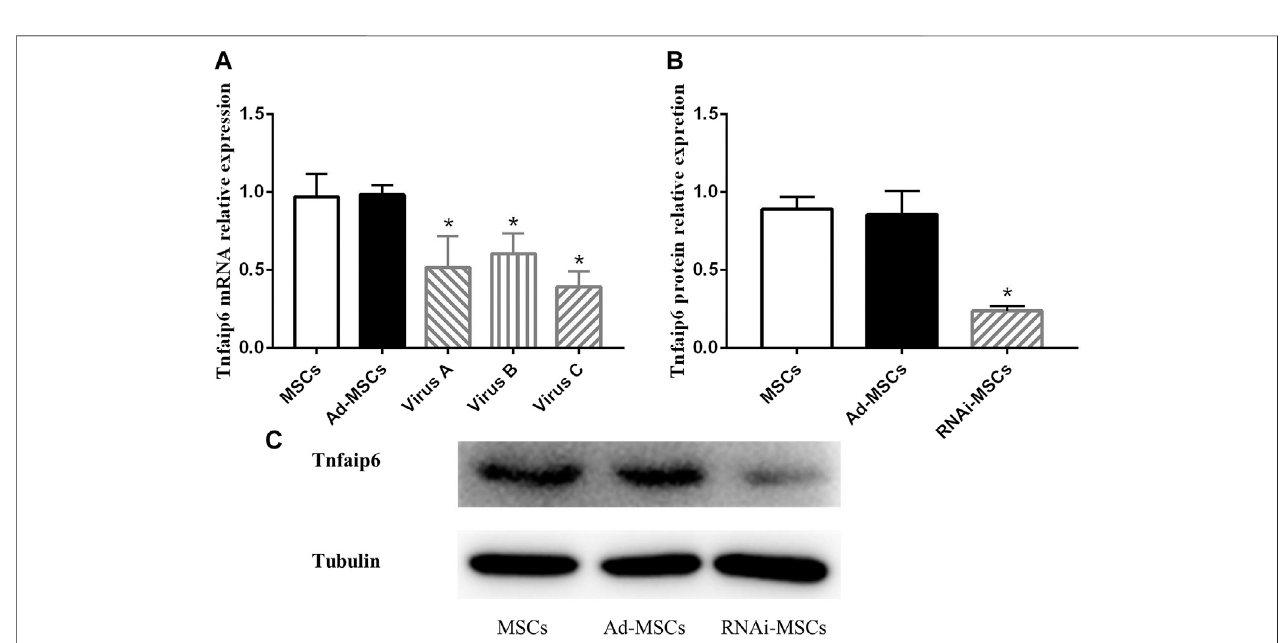
FIGURE 4 | Tnfaip6 was knocked down in BM-MSCs after infection by recombinant RNAi adenovirus. (A) Relative expression levels of TSG-6 mRNA detected by RT-qPCRinMSCs,Ad-MSCs,andRNAi-MSCs; (B,C) relativeexpressionlevelsofTnfaip6proteindetectedbyWesternblottinginMSCs,Ad-MSCs,andtargetCRNAi- MSCs. MSCs: uninfected control BM-MSCs; Ad-MSCs: BM-MSCs infected with control adenovirus; and RNAi-MSCs: BM-MSCs infected with recombinant Tnfaip6 RNAi adenovirus C. * p < 0.05 compared to MSCs or Ad-MSCs group. n (cid:2) 3 per group.